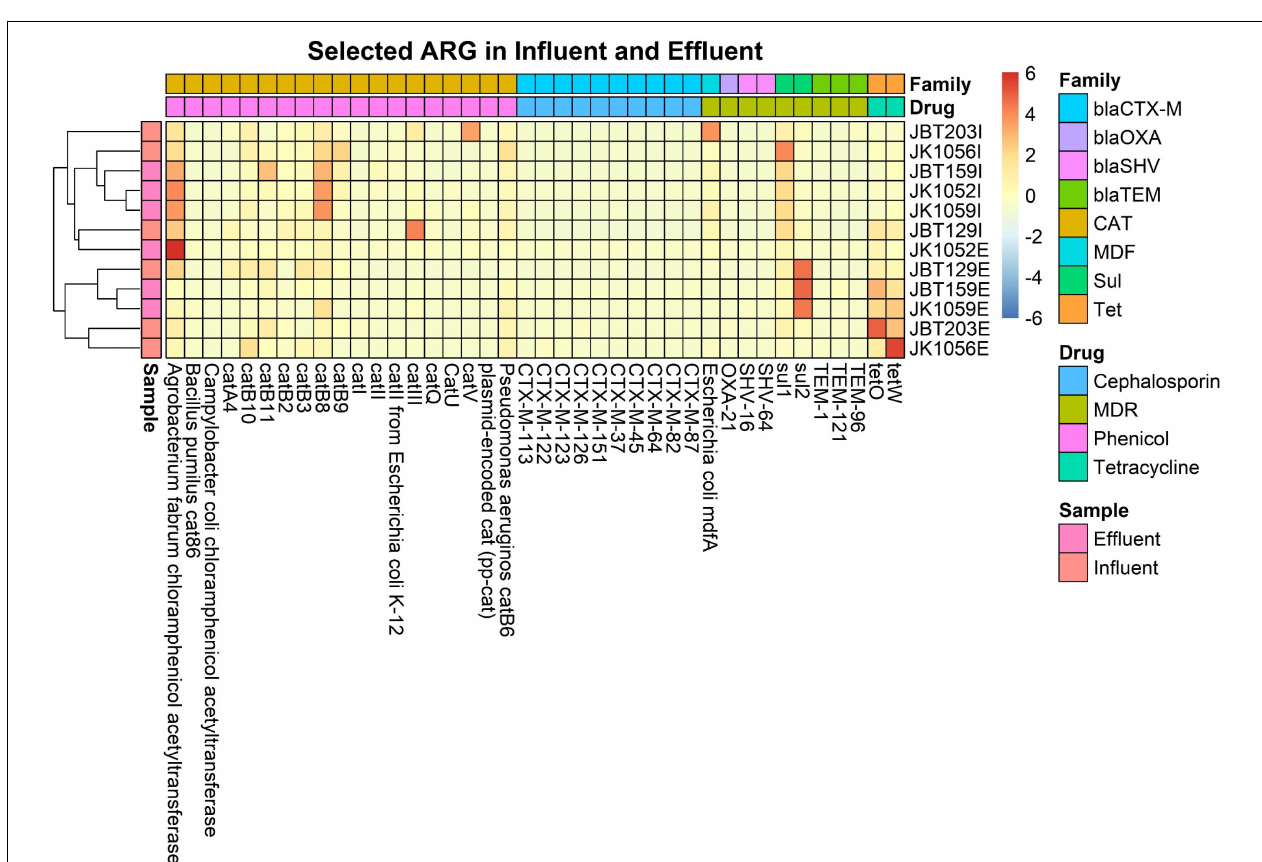
FIGURE 10 | Heat map of 40 selected ARG from 8 interest ARG families, in all 6 influent and 6 effluent WWTP samples.